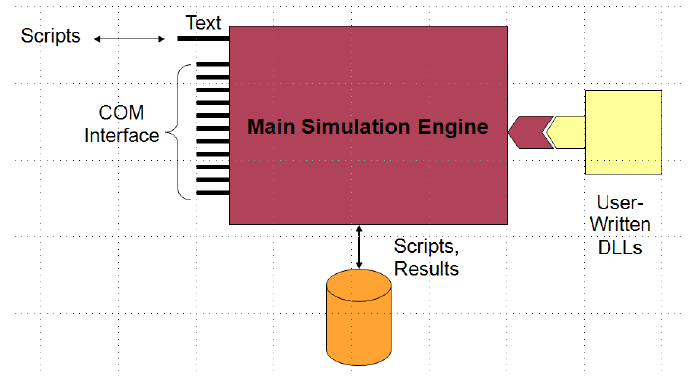
Figure 1. Open Distribution System Simulator (OpenDSS) Model Setup.